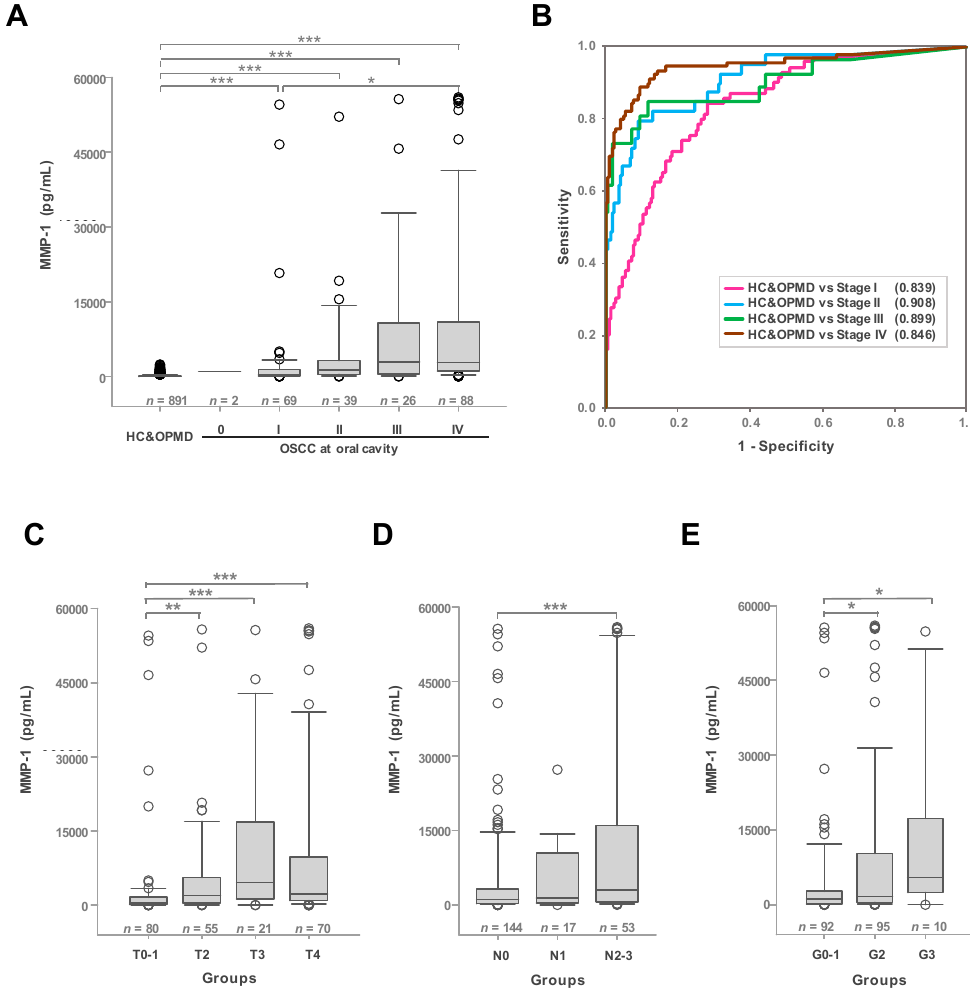
Figure 4. Di ff erential expression levels of salivary MMP-1 in oral cavity cancer patients with advanced stages and grades. ( A ) Associations between salivary MMP-1 content in HC, OPMD, and di ff erent stages (0, I, II, III, and IV) of oral cavity cancer. * p < 0.05, ** p < 0.01, *** p < 0.001. ( B ) ROC curve showing the diagnostic e ffi cacy of salivary MMP-1 for di ff erent stages (I–IV) of oral cavity cancer versus non-cancerous groups (HC and OPMD). ( C – E ) Associations between salivary MMP-1 content in